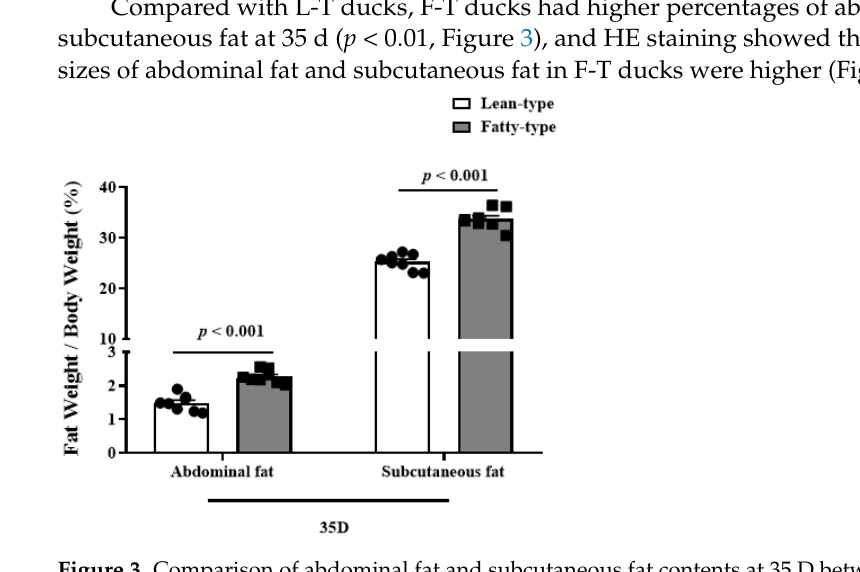
Figure 4. Representative H&E staining pictures of the abdominal adipose cell ( a ) and subcutaneous adipose cell ( b ) of 21 D, 28 D, and 35 D old ducks. The scale bar is 50 μm. Abbreviations: H&E, hematoxylin, and eosin.